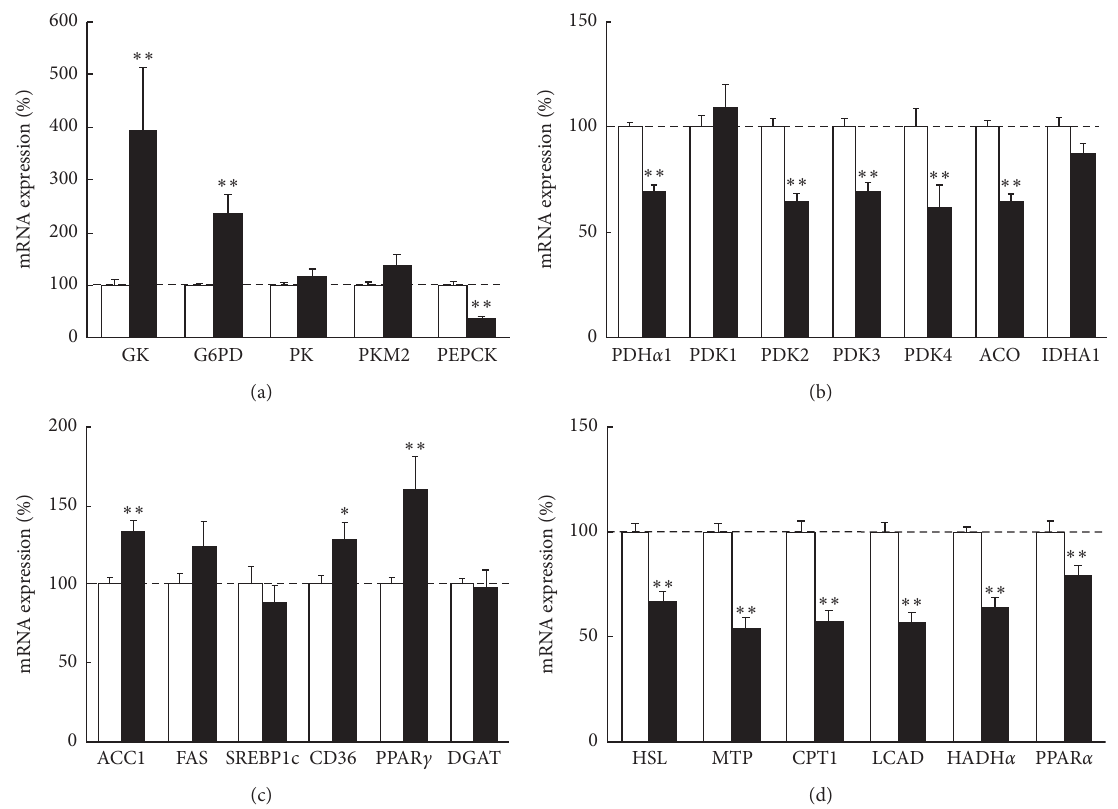
Figure 1: Metabolic gene expression in cancer tissues relative to noncancer tissues in human HCC samples. Quantitative RT-PCR analysis of metabolic genes related to (a) glucose metabolism, (b) pyruvate metabolism, tricarboxylic acid (TCA) cycle, (c) fatty acid (FA) synthesis and uptake, (d) triglyceride (TG) hydrolysis and secretion, and β -oxidation. The gene expression levels of cancer tissues were normalized to those of noncancer tissues and were presented as mean ± SE. ∗ p < 0 . 05 and ∗ ∗ p < 0 . 01 vs. noncancer tissue. GK, glucokinase; G6PD, glucose-6-phosphate dehydrogenase; PK, pyruvate kinase; PEPCK, phosphoenolpyruvate carboxykinase; PDH, pyruvate dehydrogenase; PDK, pyruvate dehydrogenase kinase; ACO, aconitase; IDH, isocitrate dehydrogenase; ACC, acetyl-coenzyme A carboxylase; FAS, fatty acid synthase; SREBP, sterol regulatory element-binding protein; PPAR, peroxisome proliferator-activated receptor; DGAT, diacylglycerol acyltransferase; HSL, hormone-sensitive lipase; MTP, microsomal triglyceride transfer protein; CPT, carnitine palmitoyltransferase; LCAD, long chain acyl-coenzyme A dehydrogenase; HADH, hydroxyacyl-coenzyme A